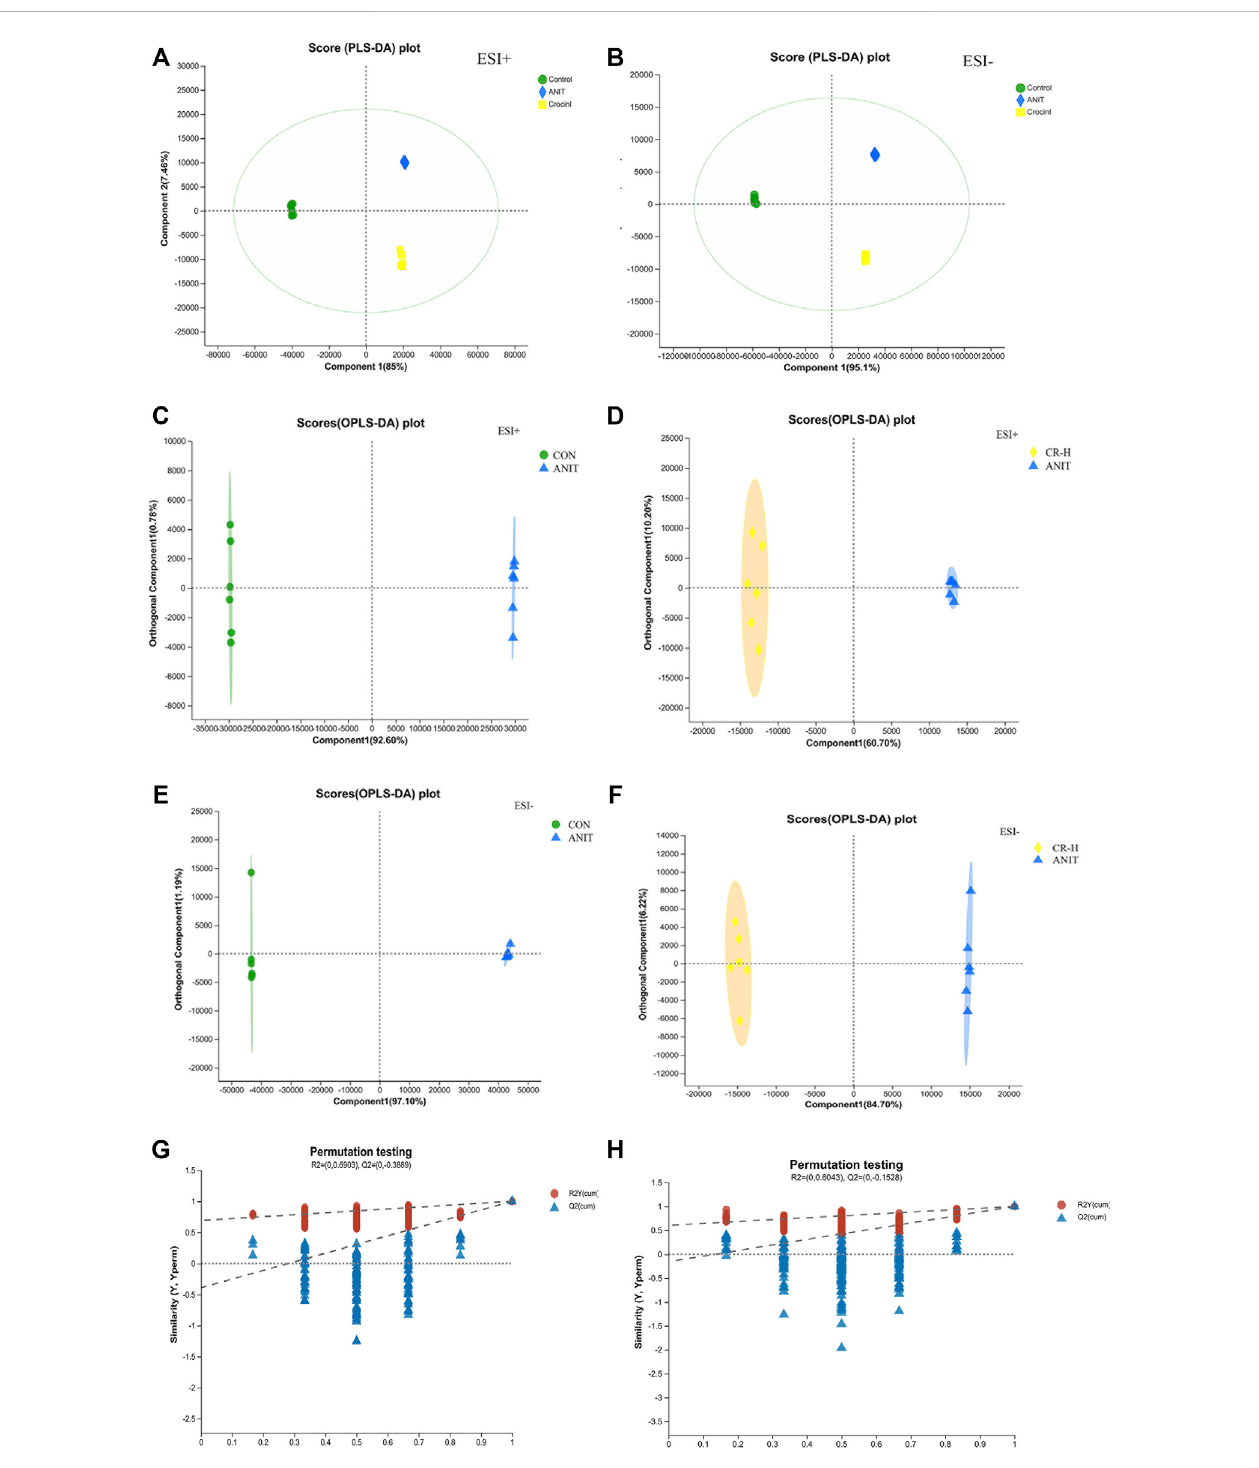
FIGURE 5 Multivariate statistical analysis of serum metabolomics. (A),(B) PLS-DA score plots of serum metabolomics analysis in theESI + model and ESI − ANIT; (C) OPLS-DA score plots of CON and ANIT in positive mode; (D) OPLS-DA score plots of CON and CR-H in positive mode; (E) OPLS-DA score plots of CON and ANITinnegativemode; (F) OPLS-DAscoreplotsofCONandCR-Hinnegativemode; (G) 200-permutationtestoftheOPLS-DAmodelfortheCONandANIT groups; (H) 200-permutation test of the OPLS-DA model for the CR and ANIT